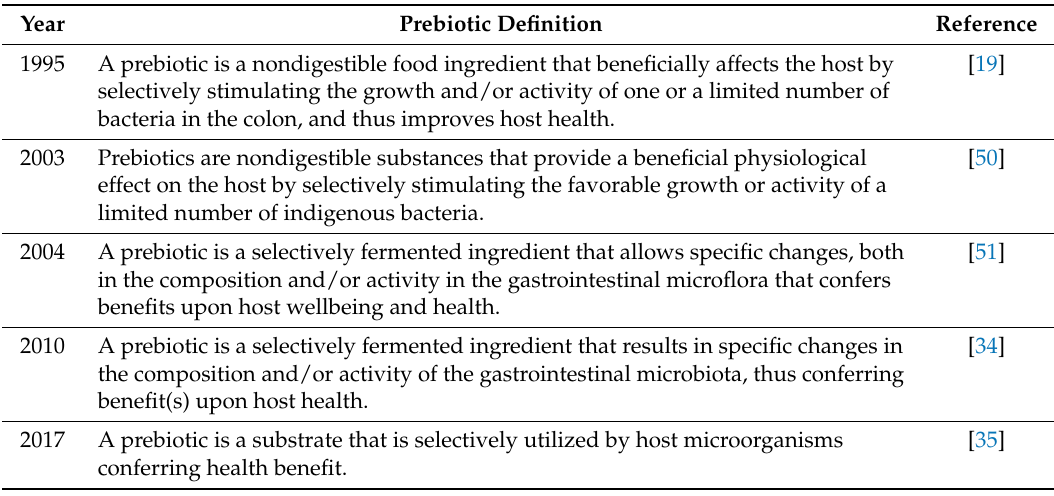
Table 1. Main prebiotic definitions evolved from 1995 until